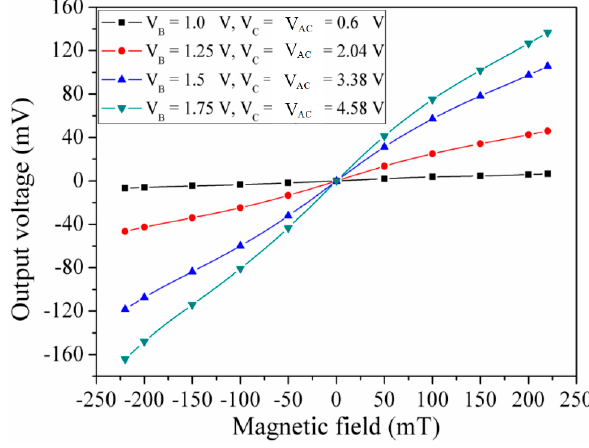
Figure 10. Measured output voltage in the x ‐ direction MF.